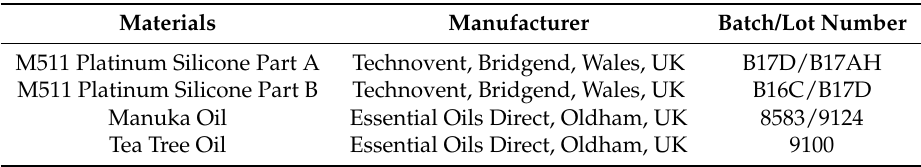
Table 3. Materials utilized in this research